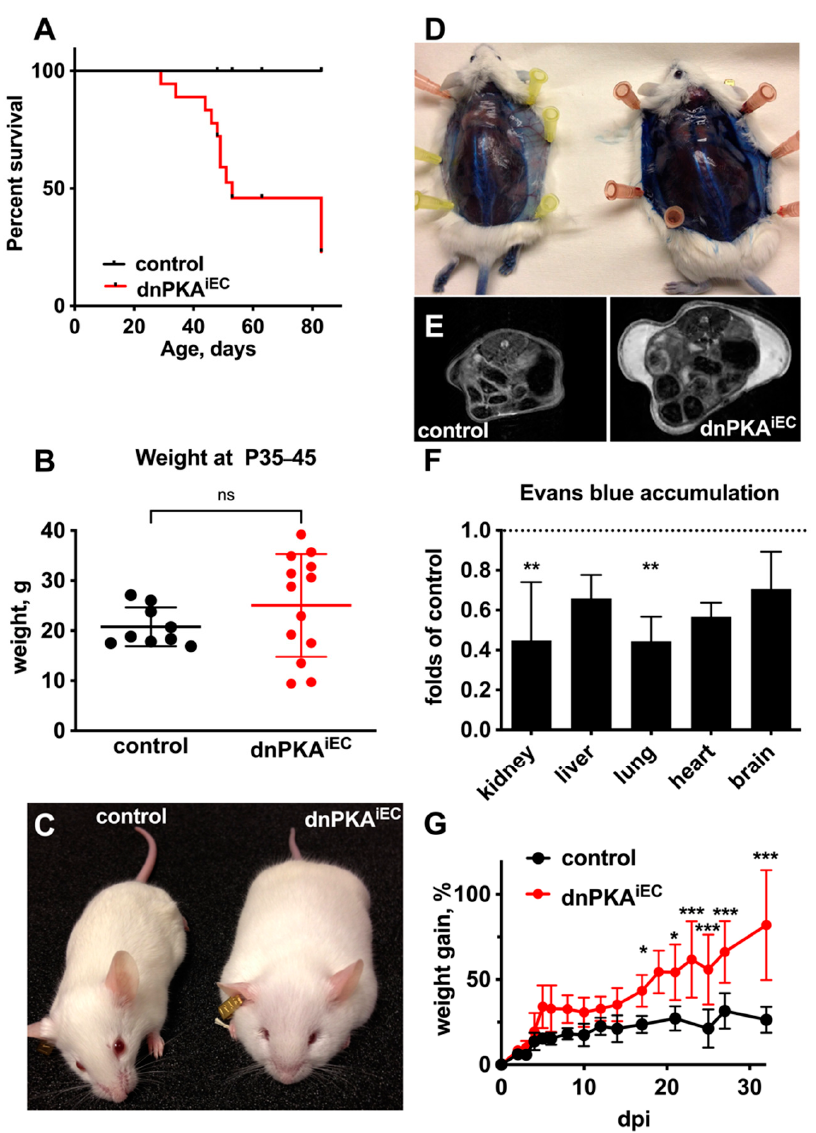
Figure 1. Inhibition of endothelial PKA results in subcutaneous edema and premature death. ( A – E ) dnPKA iEC mice and their control (Tg( Cdh5-cre/ERT2 ) 1Rha without floxed transgenes) littermates were injected with 50 mg tamoxifen at postnatal days 1, 2 and 3. ( A ), Inhibition of endothelial PKA results in premature death. In total, 15 control and 18 dnPKA iEC mice from 4 different litters were analyzed. ( B ), dnPKA iEC mice have broader weight distribution than their control littermates, with some gaining more weight and some failing to gain weight normally. Here, 9 control and 13 dnPKA iEC mice from 4 different litters were analyzed. Data are presented as scatter blot with individual